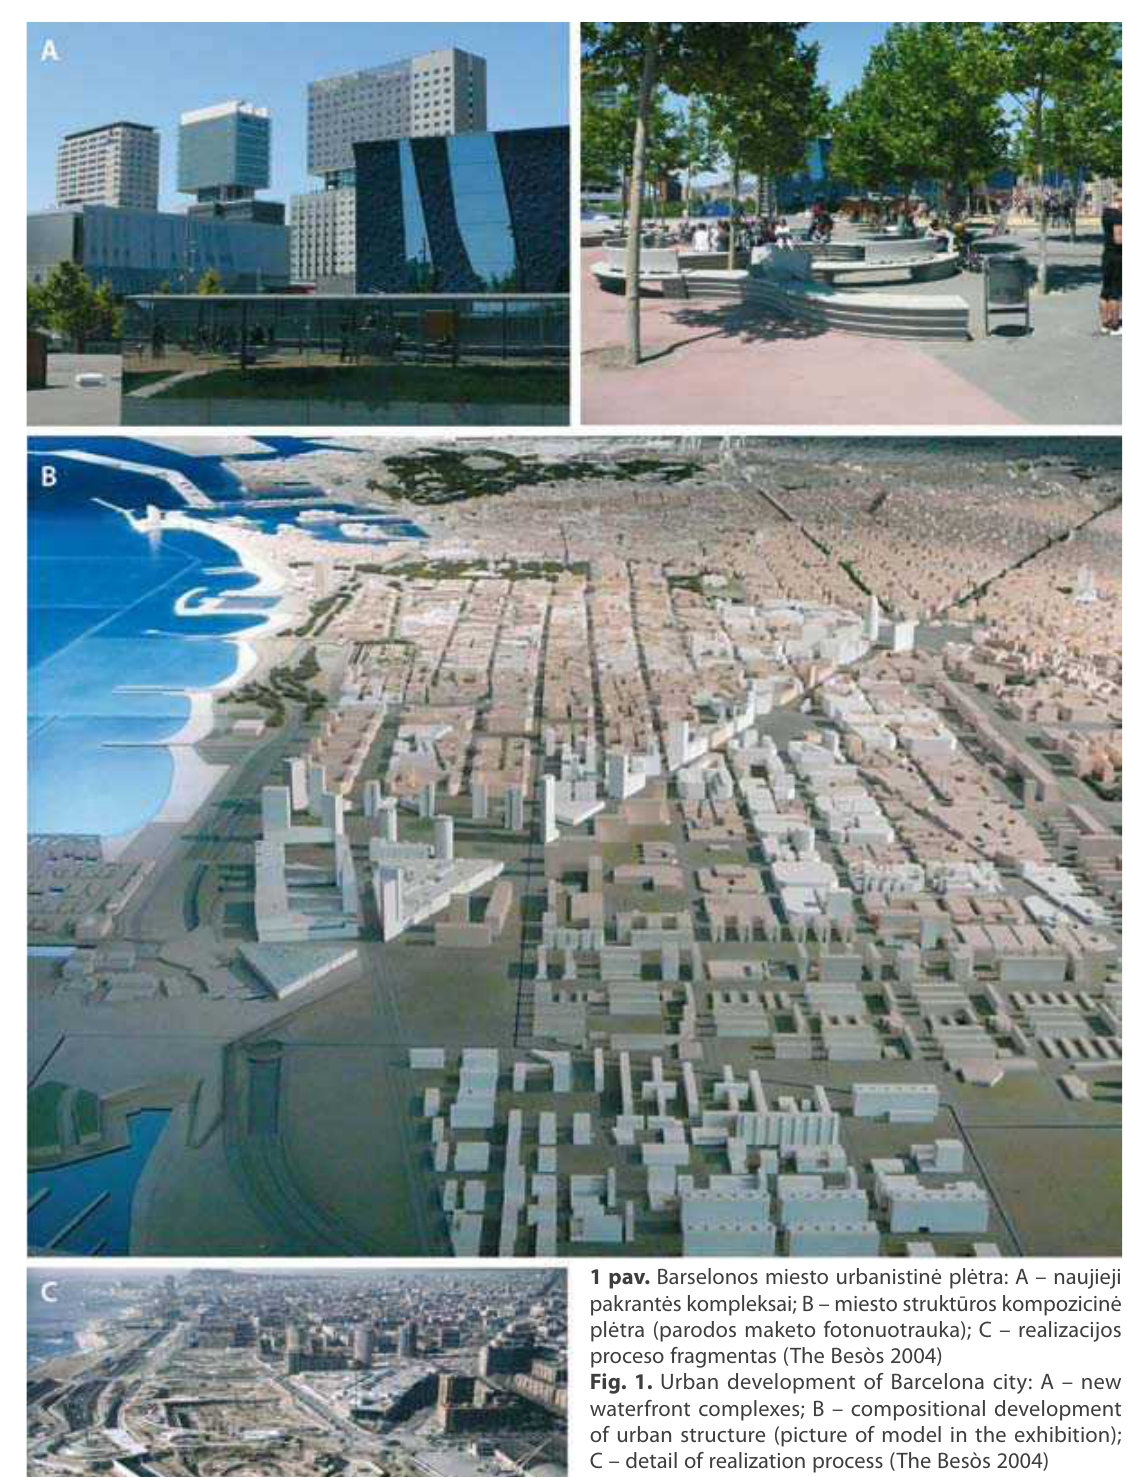
1 pav. bar se lo nos mies to ur ba nis ti nė plėt ra: A – nau jie ji pa kran tės kom plek sai; b – mies to struk tū ros kom po zi ci nė plėt ra (pa ro dos ma ke to fo to nuot rau ka); C – re a li za ci jos pro ce so frag men tas (The besòs 2004) Fig. 1. Ur ban de ve lop ment of bar ce lo na ci ty: A – new wa ter front com ple xes; b – com po si tio nal de ve lop ment of ur ban struc tu re (pic tu re of mo del in the ex hi bi tion); C – de tail of re a li za tion pro cess (The besòs